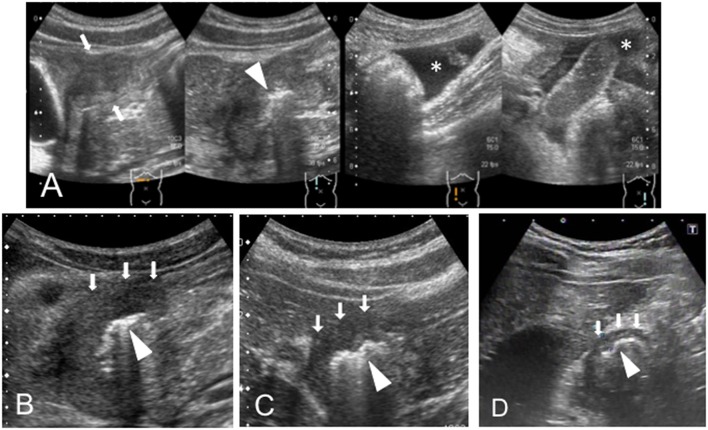
(A) Case 1, (B) Case 2, (C) Case 3, and (D) Case 4. The HH sign—extensive hyperplasia of the duodenal wall (white arrows) and the hyperechoic inner layer (white head-arrow)—was observed. The peritoneal fluid (*) is identified in case 1.